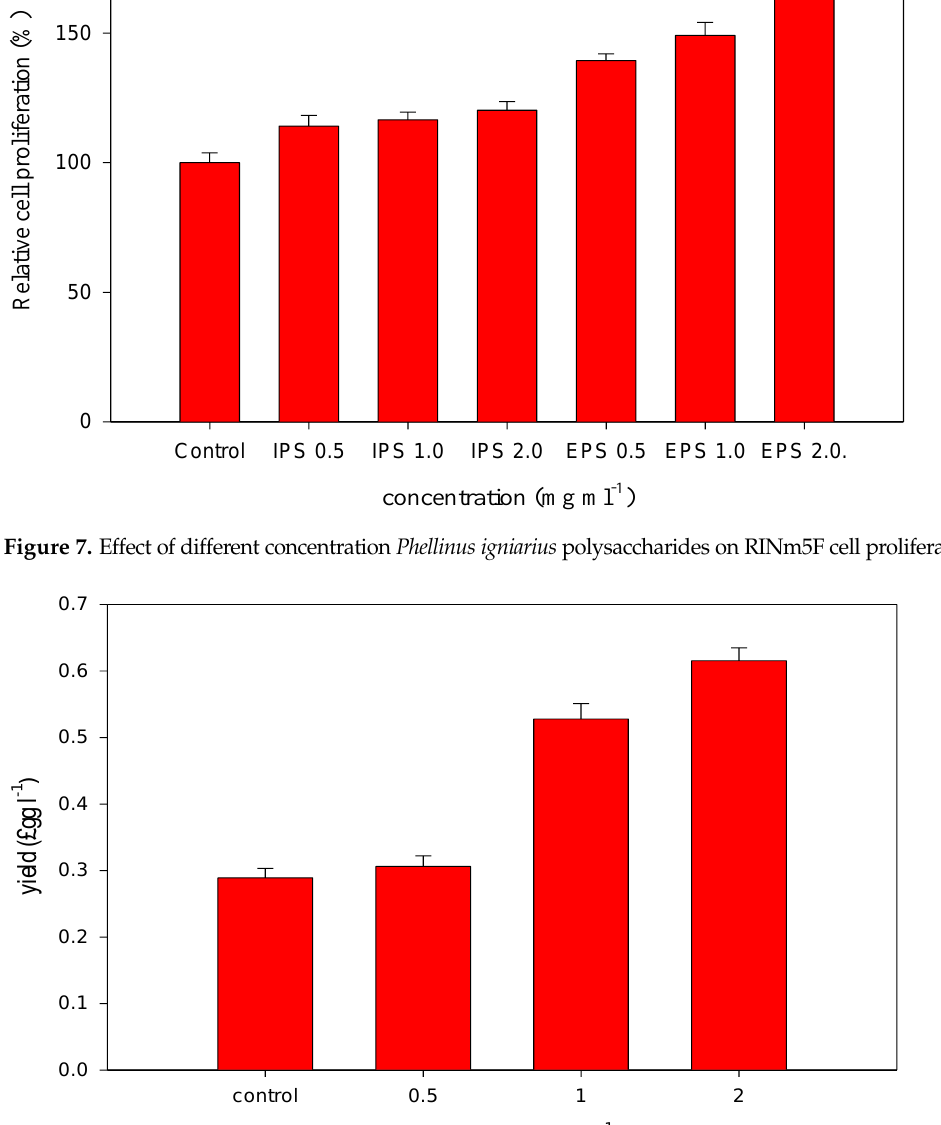
Figure 8. Effect of different concentration Phellinus igniarius exopolysaccharides on RINm5F insulin secretion.